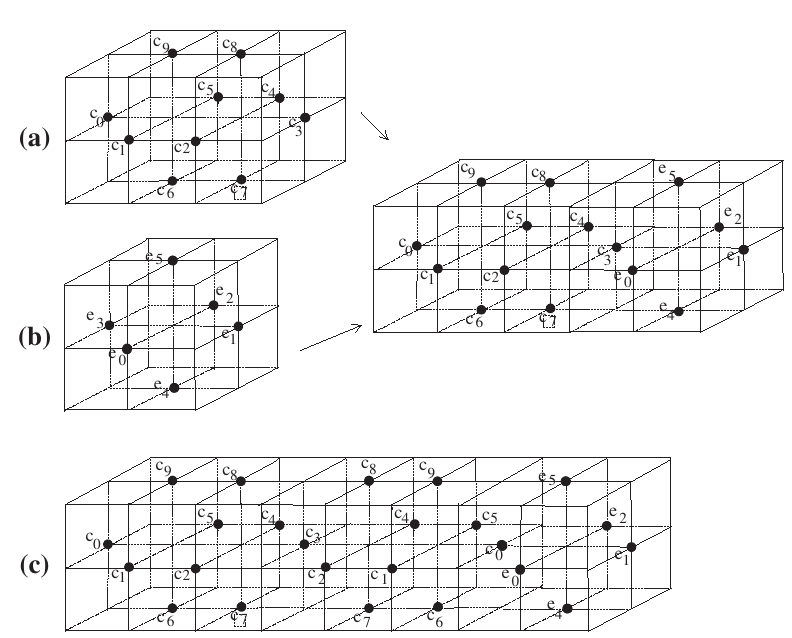
Figure 6. ( a , b ) Explanation of the process of establishing MSS 18 ∨ MSS (cid:48)